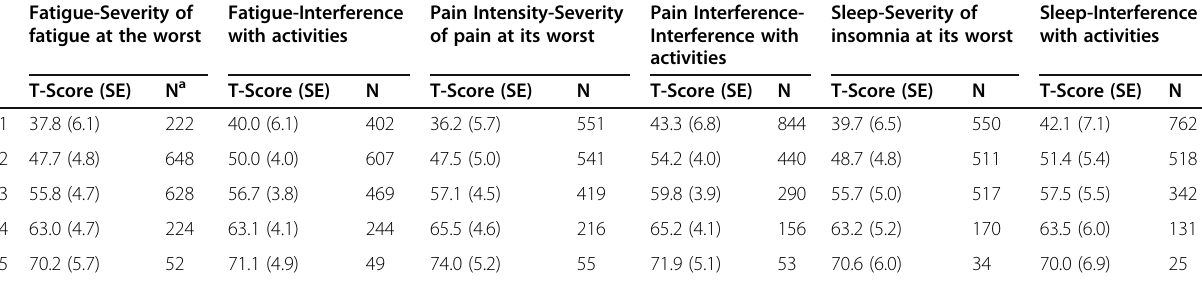
Table 4 Cross-walk Table for the PRO-CTCAE items for fatigue, pain intensity, pain interference, and sleep disturbance Fatigue-Severity of Fatigue-Interference fatigue at the worst with